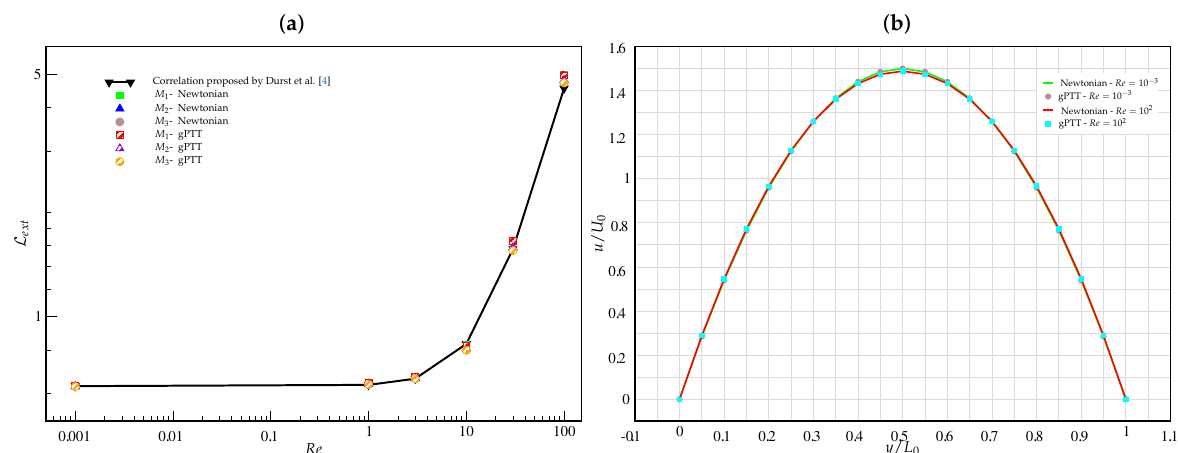
Figure 7. (a) Comparison between the development length obtained with the gPTT model (with Wi = 0.001), a Newtonian fluid and the correlation proposed by Durst et al. [4], for three different meshes M 1 , M 2 and M 3 . (b) Velocity profiles in the fully developed region for mesh M 3 , considering the gPTT and Newtonian models, for Re = 0.001 and Re = 100.